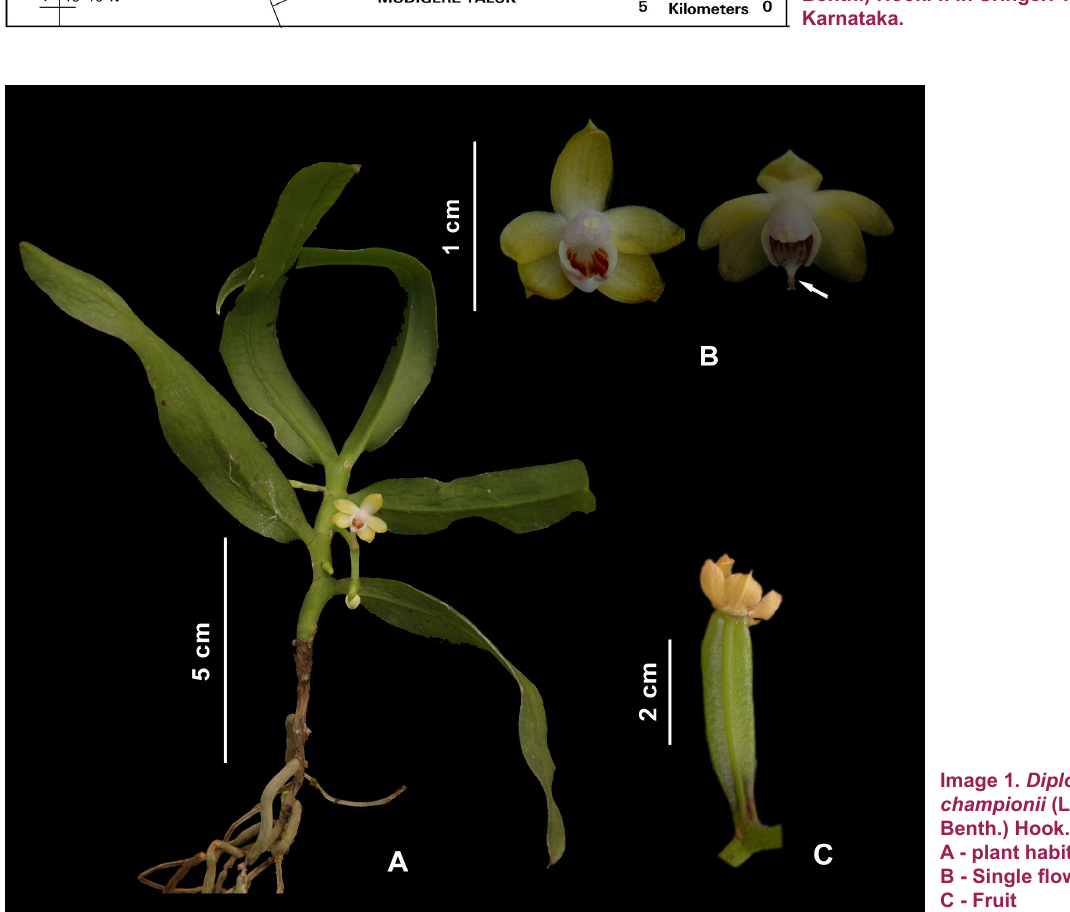
FruitFigure 1. Collection localities of Diploprora championii (Lindl. Ex Benth.) Hook. f. in Sringeri Taluk, Karnataka.